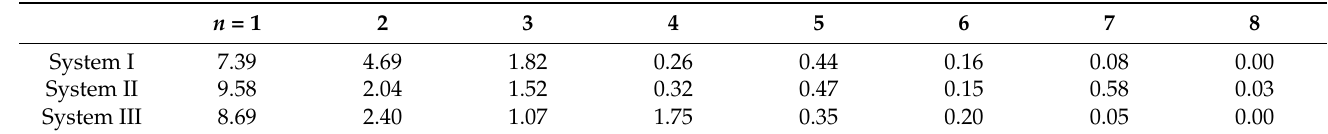
(cid:105) , during the 12 ns production n